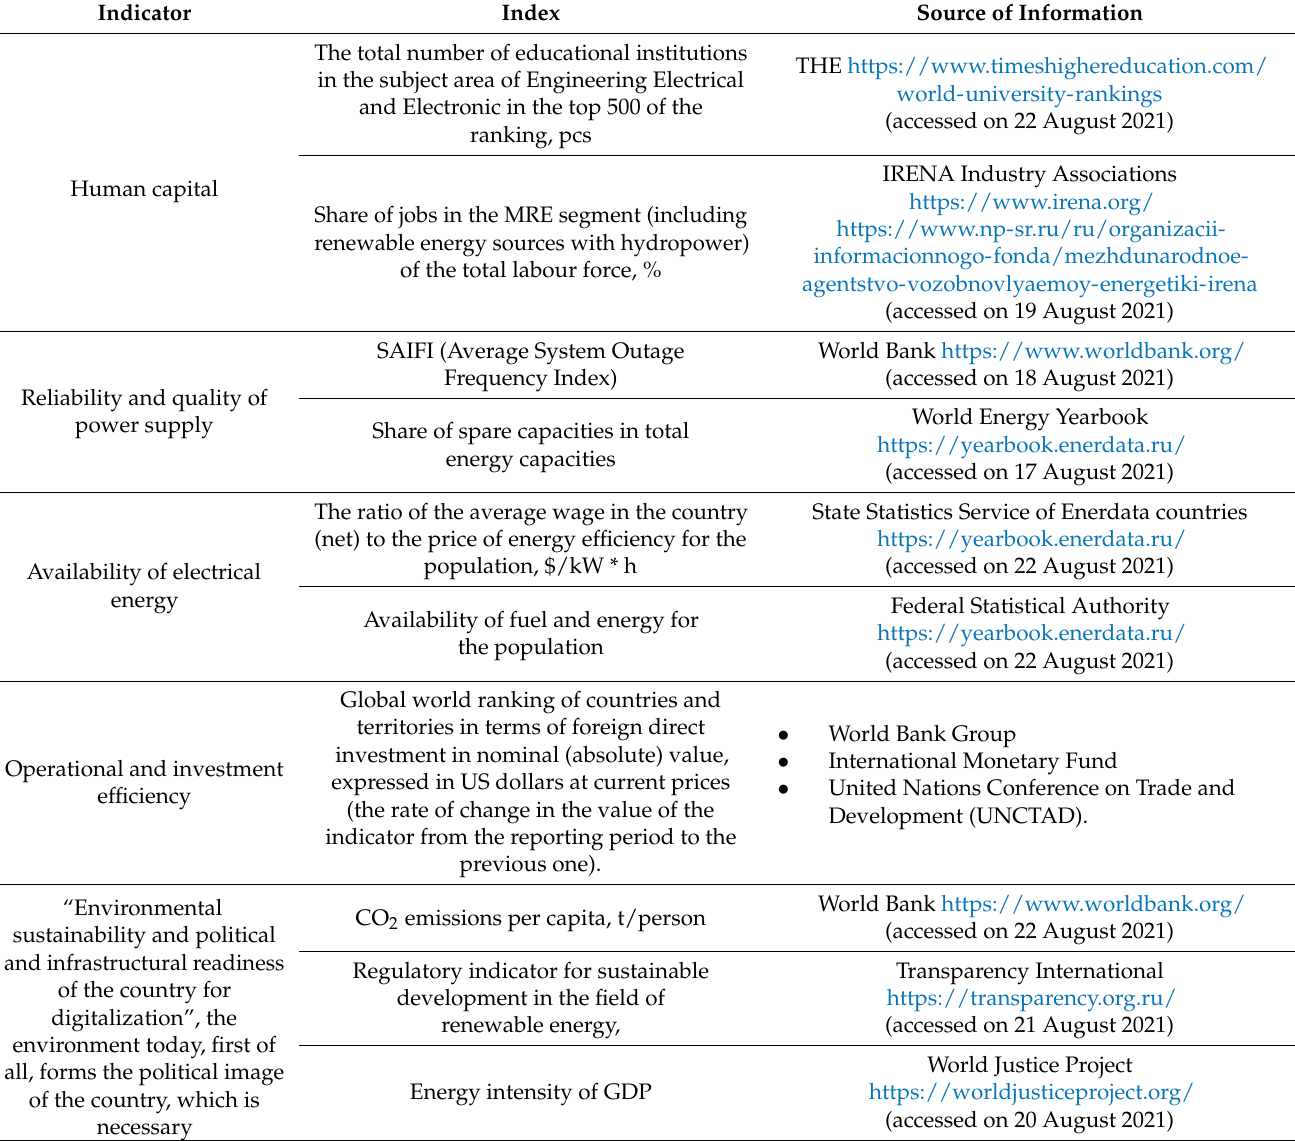
Table 6. The system of indicators for assessing the readiness for digitalization of countries in the energy sector (developed by the